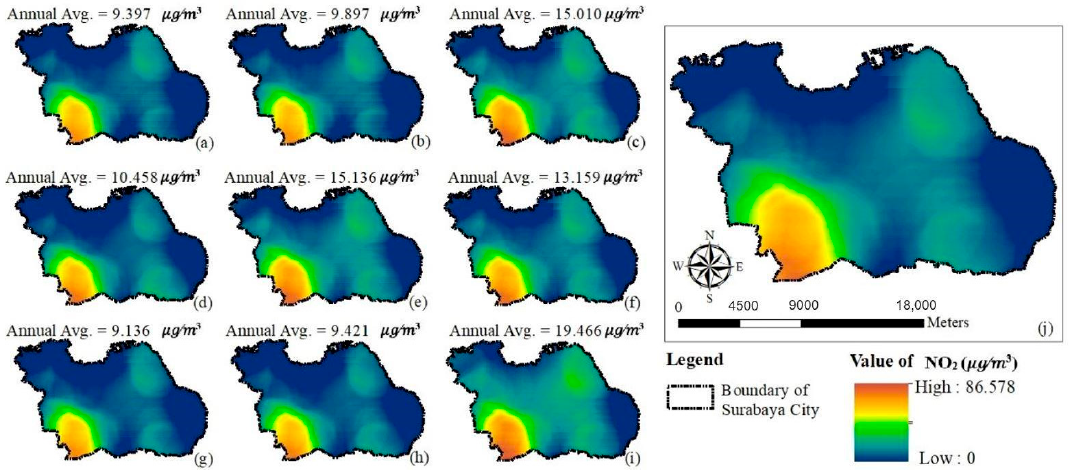
Figure 5. Prediction maps of NO 2 concentration variations using GWR model: ( a ) 2010 ( b ) 2011 ( c ) 2012